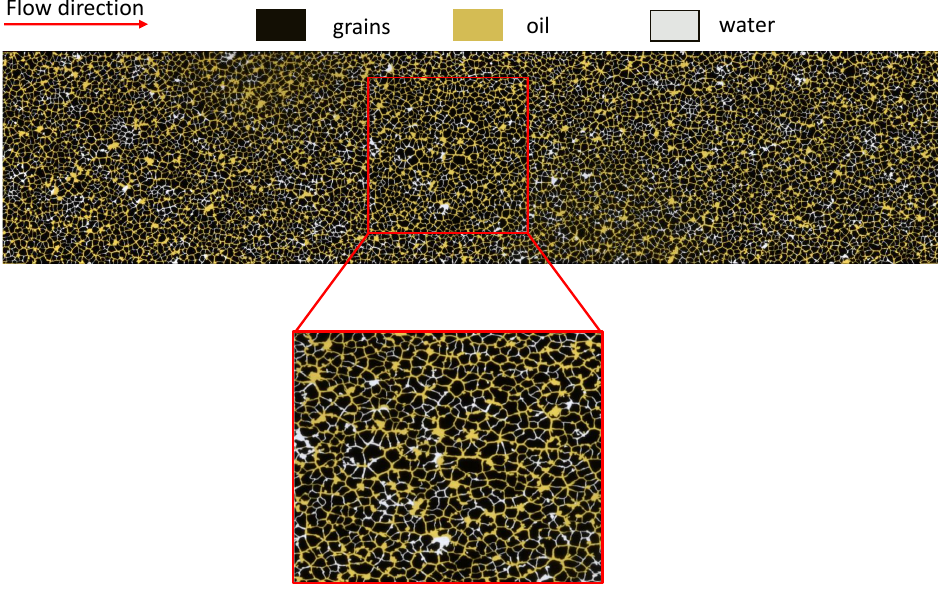
Figure 3. Saturated microchip: black indicates the grains; brown represents oil; white indicates